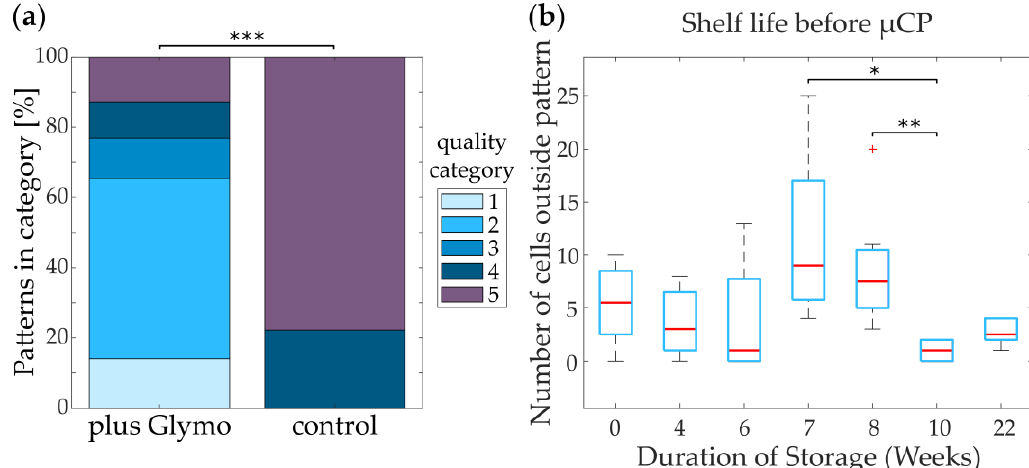
Figure 6. Patterning efficiency and long term stability of neurons on glass functionalized with Glymo and PLL, followed by DDA. ( a ) Amount of cell patterns at DIV 5 in different quality categories after printing and neuronal growth (see Supplementary Figure S4; n = 78) when compared with untreated glass (control; n = 9). Statistical significance was tested with the Mann-Whitney U test (p = 9.6e −6 ). ( b ) Long term shelf life of Glymo-functionalized glass, measured by the number of cells growing outside of patterns at DIV 5 after up to 22 weeks of substrate storage before µCP. Statistical significance was tested for all samples with the Kruskal-Wallis H-test for independent samples (p = 0.0010). For individual comparison, Dunn’s multiple comparison test with Bonferroni correction was used (p values < 0.05: p week7 / week10 = 0.0044; p week8 / week10 = 0.0237; see Supplementary Table S1).